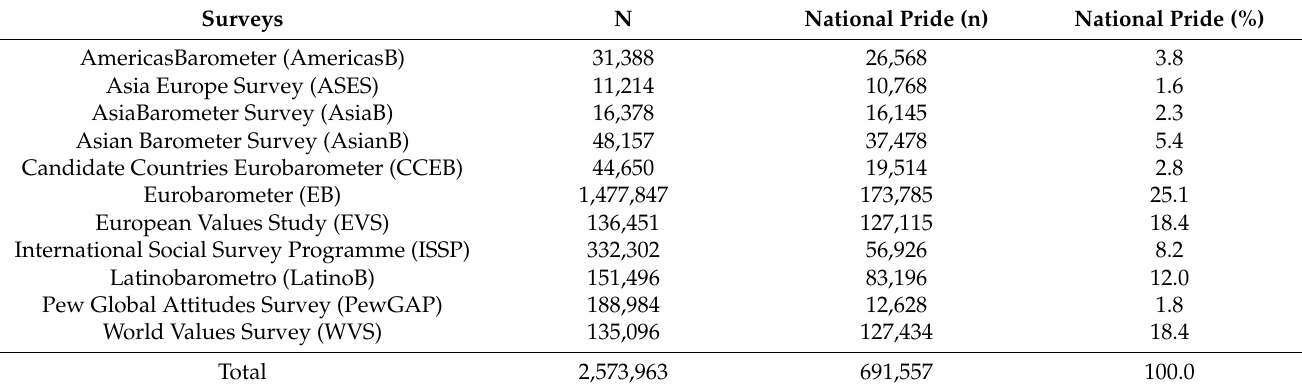
Table A1. Surveys and respondents across countries and years (1981–2018), number and percentage (by survey) of respondents who answered the national pride